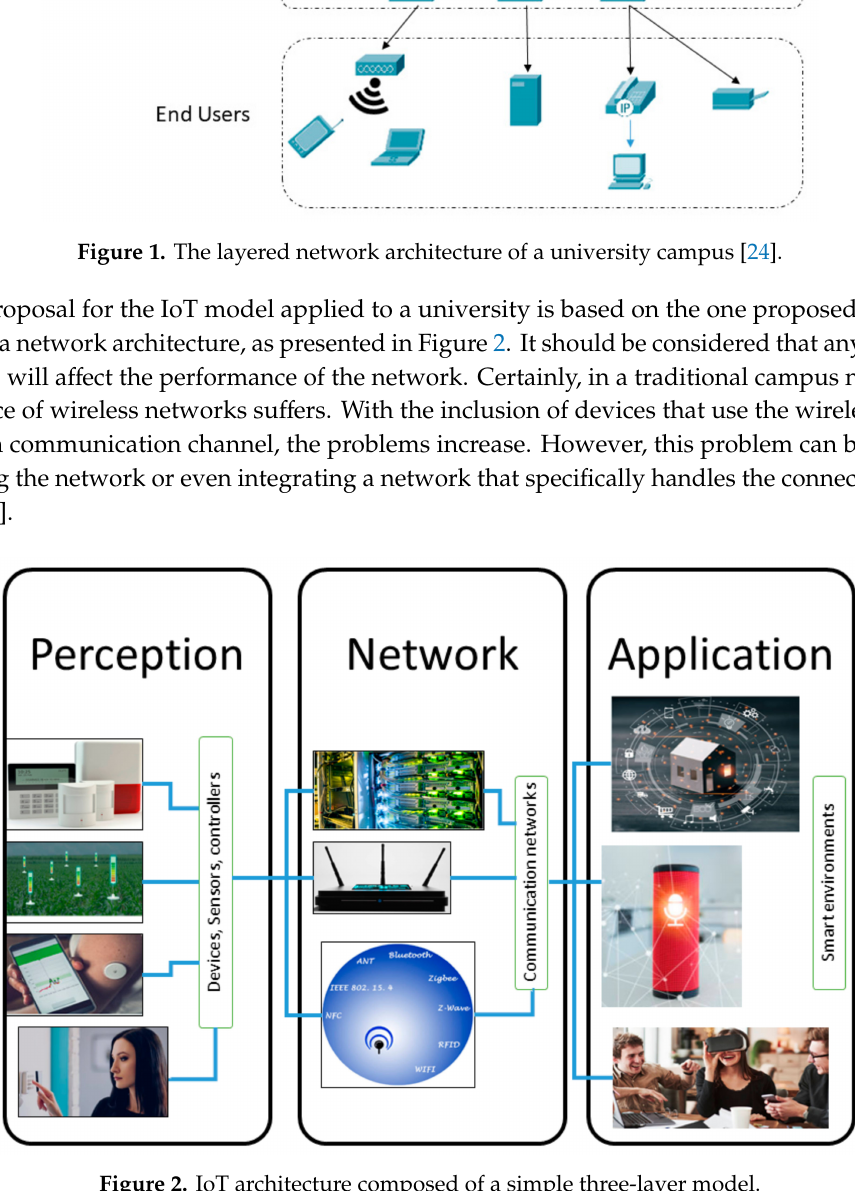
Figure 2. IoT architecture composed of a simple three-layer